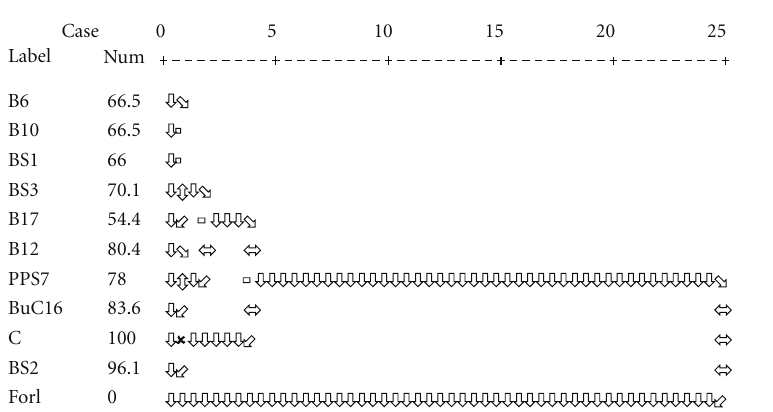
Figure 4: Dendogram grouping of 9 strains isolated from VPC, based on healthy plant percentage. Experience realized in situ under green house